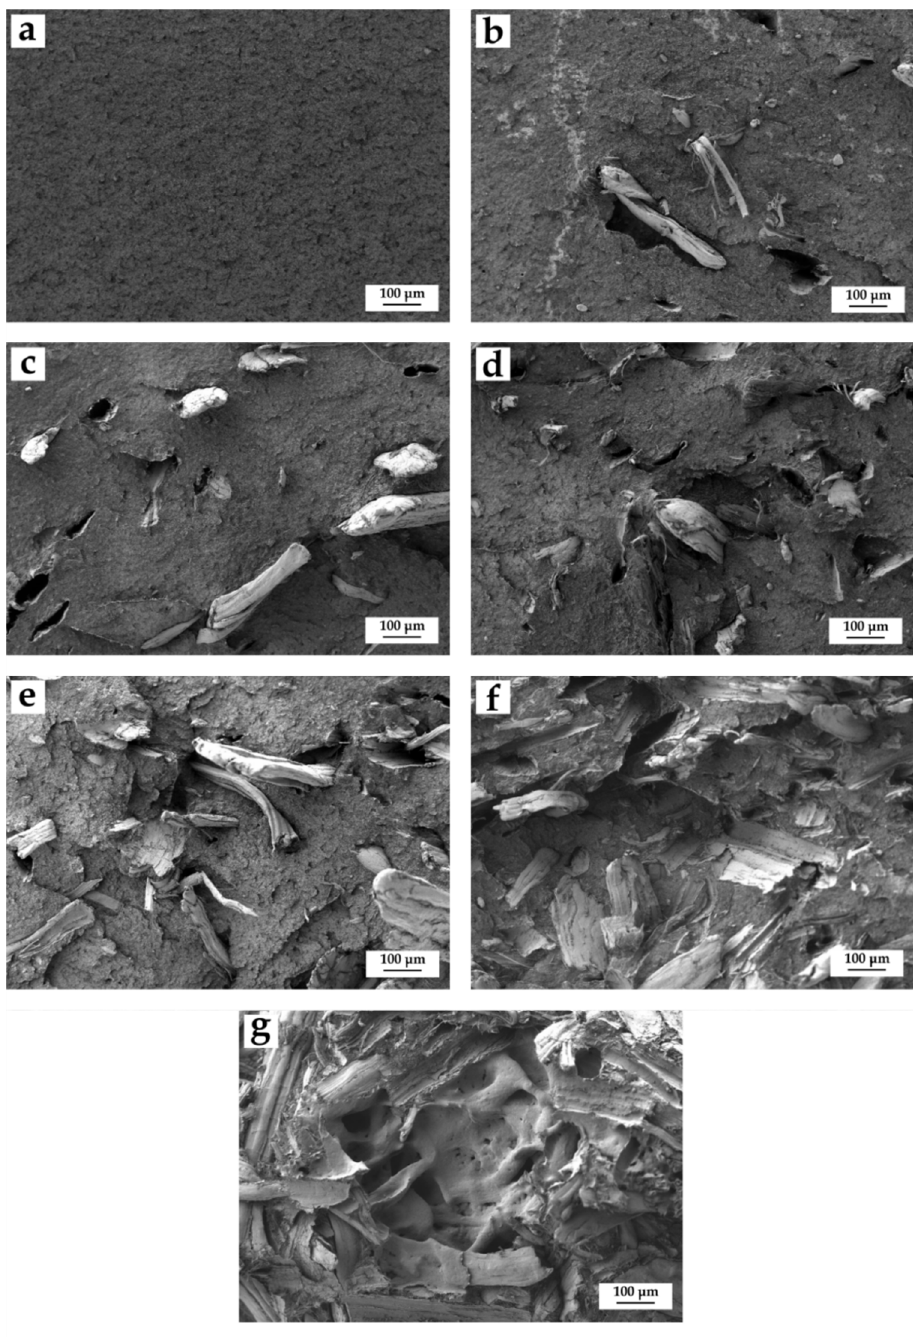
Figure 3. Field emission scanning electron microscopy (FESEM) images at 100x of the fracture surfaces of the BioHDPE/HF composites: ( a ) BioHDPE; ( b ) BioHDPE/2.5HF/PE-g-MA; ( c ) BioHDPE/5HF/PE-g-MA; ( d ) BioHDPE/10HF/PE-g-MA; ( e ) BioHDPE/20HF/PE-g-MA; ( f ) BioHDPE/20HF; ( g ) BioHDPE/40HF/PE-g-MA.